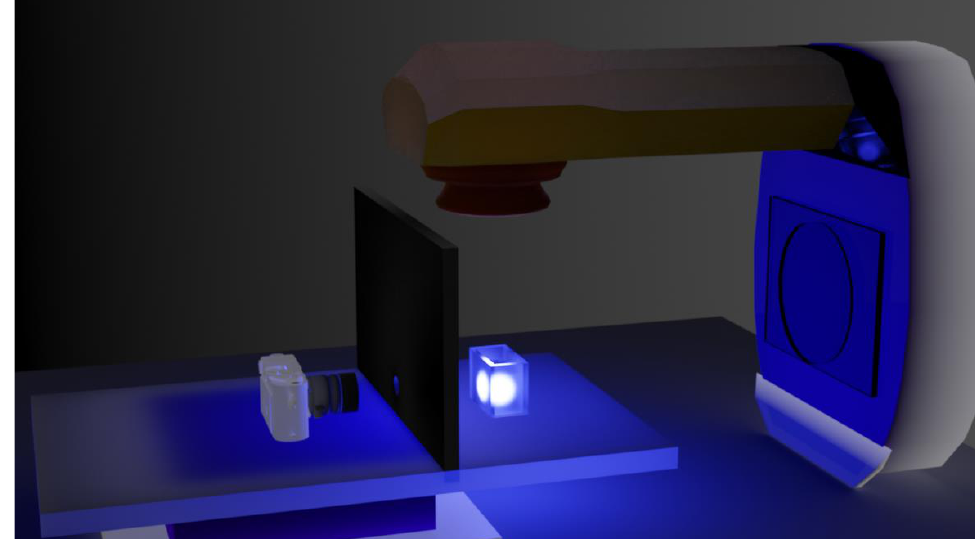
Figure 1. Schematic of the configuration of LINAC, AbLS sample, and digital camera. The distance between the head of LINAC and the AbLS sample is 1 m, and the distance between the AbLS sample and the camera is 50 cm. The AbLS sample and camera were placed on a flat table. The digital camera was positioned at 90 degrees relative to the beam axis. A partition with tiny hole was placed in front of the camera to avoid background or stray light.